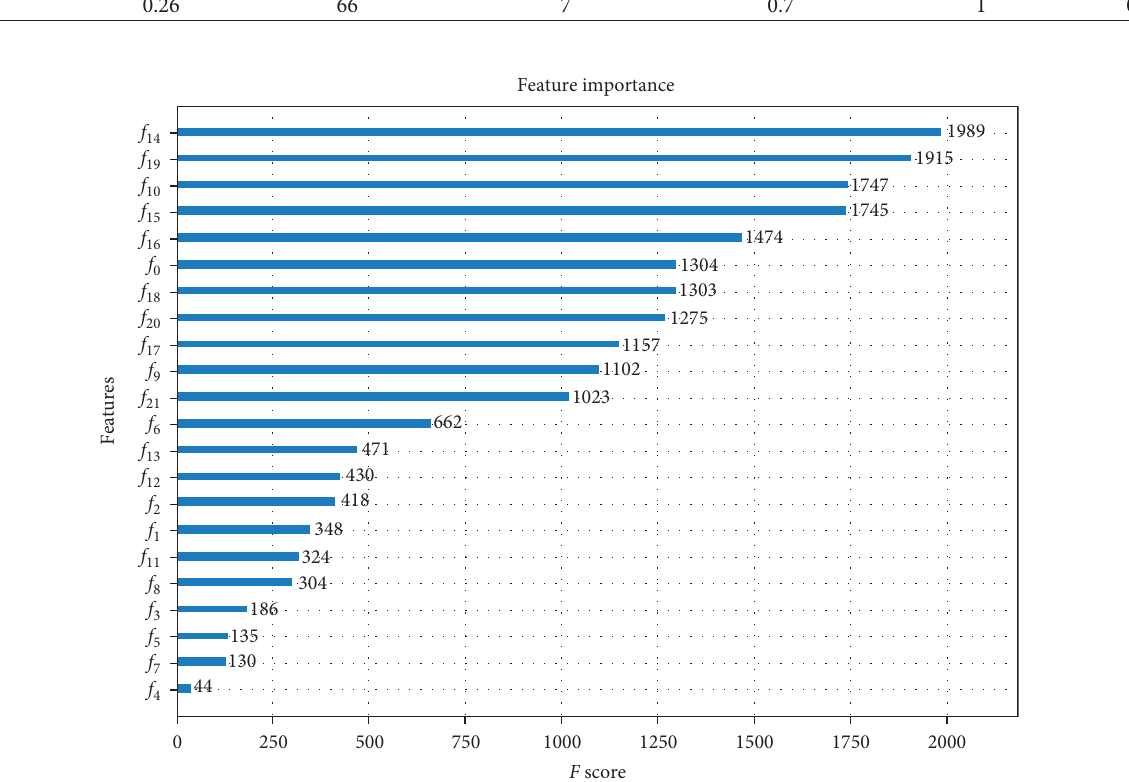
Figure 8: F score of feature vector in the EDMCN-XGBoost